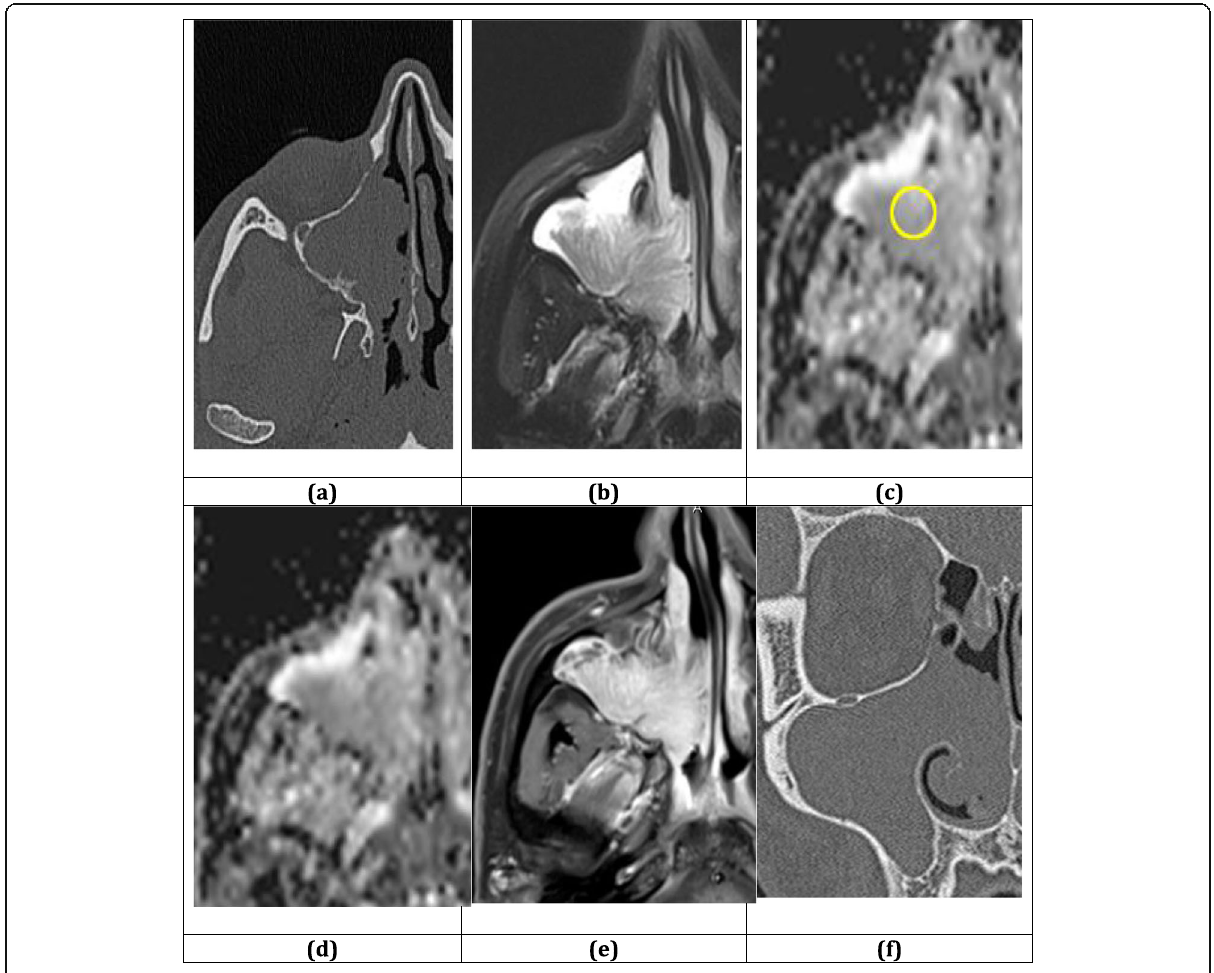
Fig. 5 A 37-year-old male with proven inverted papilloma of the right maxillary sinus. Axial computed tomography ( a ) reveals non-specific maxillary sinus opacification with focal hyperostosis at its postero-lateral wall. Axial T2-weighted image ( b ) shows linear striations divergent from the site of focal hyperostosis. T2 image also nicely differentiates obstructed secretions from solid mass reflecting moderate diffusivity with black-out effect of focal sclerosis at diffusion image ( c ) and apparent diffusion co-efficient value of 1.2 × 10 -3 cm 2 /s, as measured in apparent diffusion co-efficient map ( d ). Axial fat suppressed post-gadolinium image ( e ) reveals linear striations may be less or equal to visibility in T2-weighted image. Coronal computed tomography image ( f ) shows smooth widening of the ostio-meatal unit with nasal extension of the maxillary